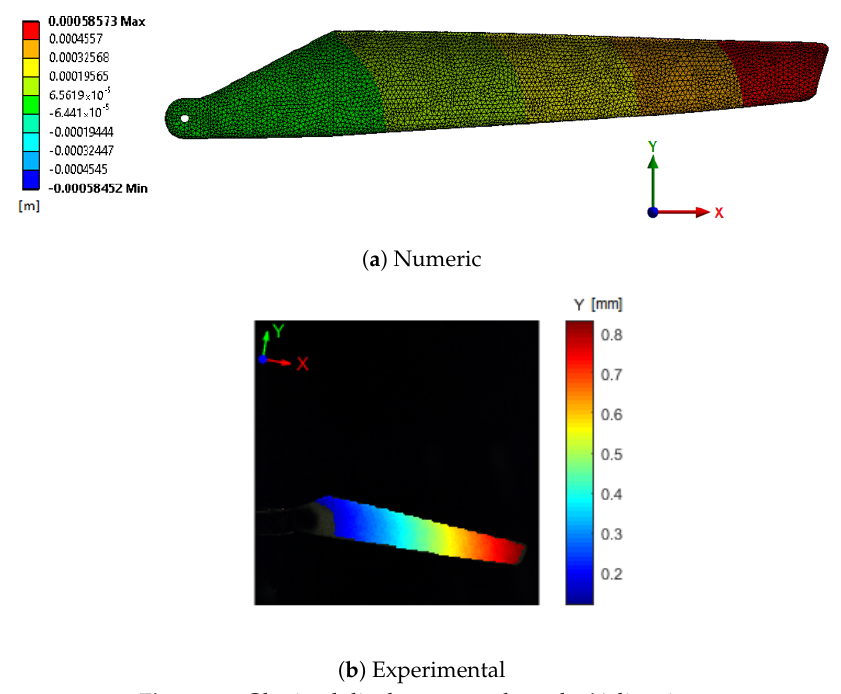
Figure 23. Obtained displacements along the Y direction.